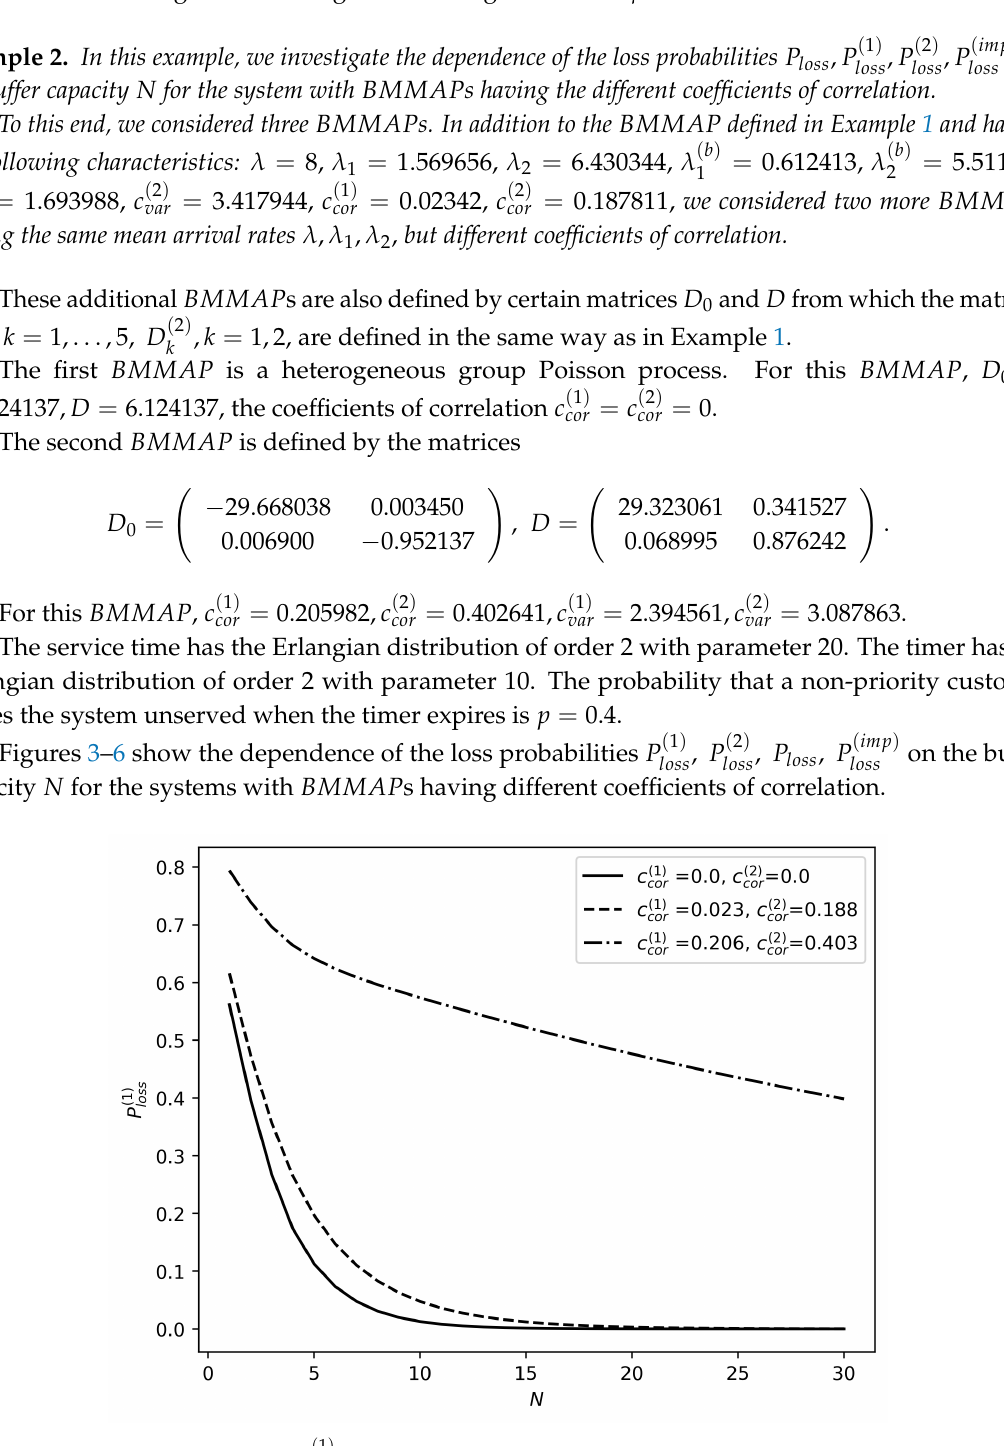
Figure 3. The loss probability P coefficients of